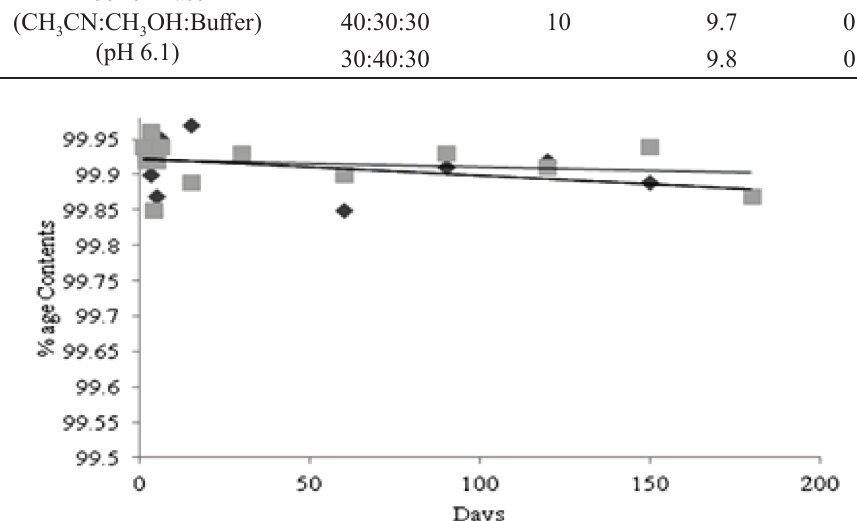
FIGURE 5 - Stability curve showing the concentration of active ingredient in venlafaxine HCl capsules vs number of days at 40 °C & 75 % RH( ■ ) and 50 °C & 75 % RH